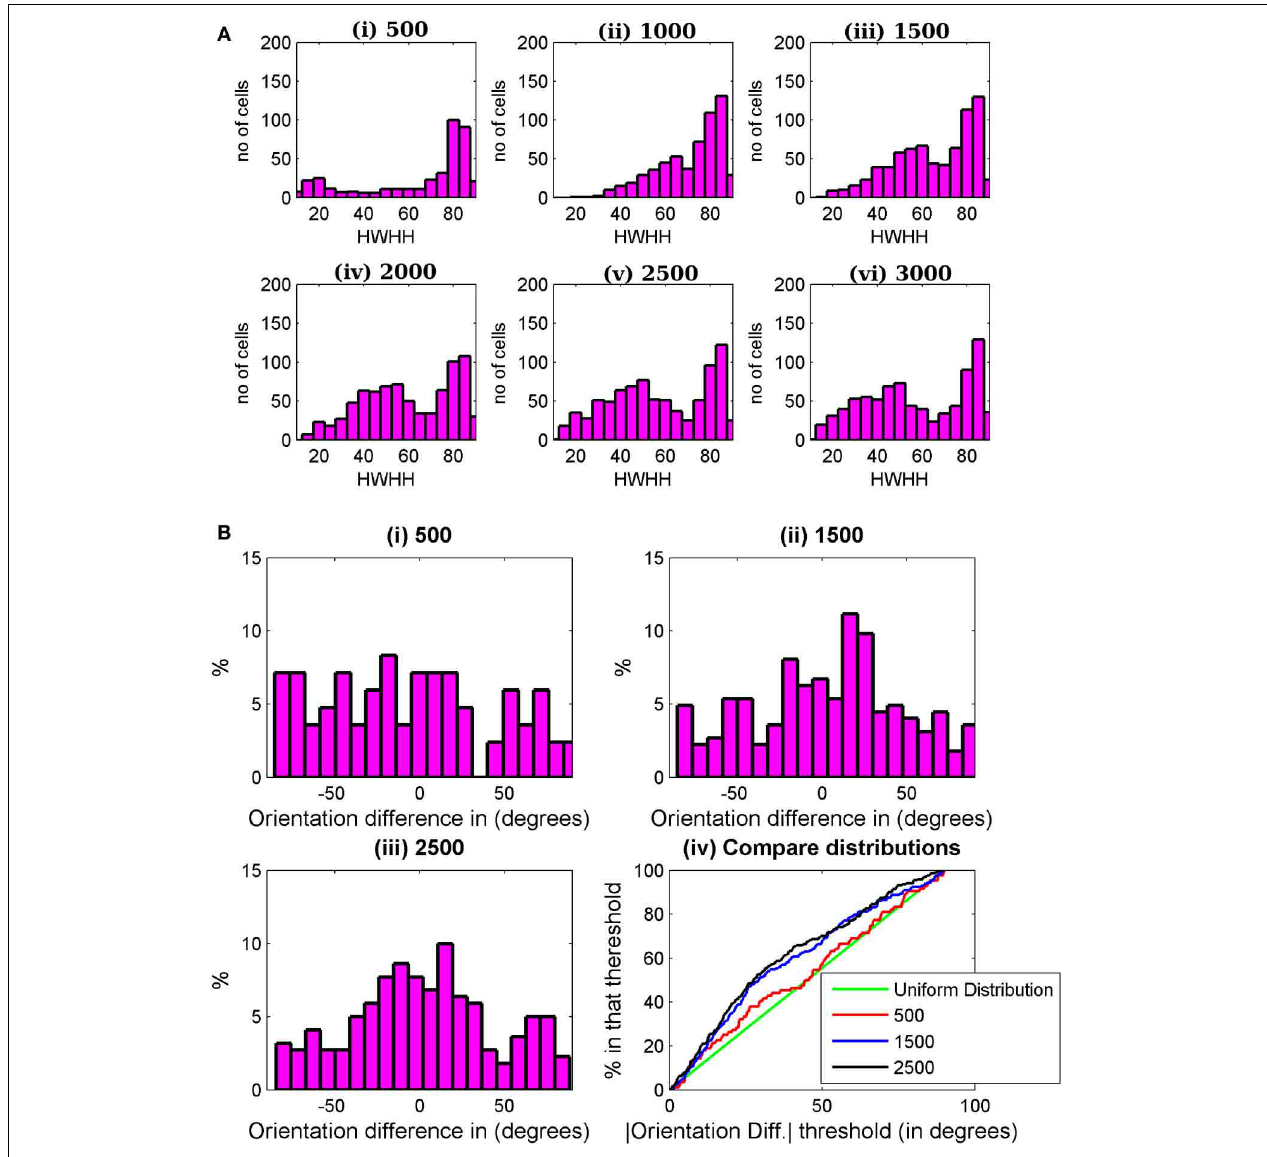
FIGURE 7 | (A) HWHH histogram for the cells in a 35 × 60 patch from the binocular region in the cortex. The histograms are shown from 500 to 3000 epochs at an interval of 500 epoch. (B) Histograms of preferred orientation difference between the two eyes at (i) 500, (ii) 1500, and (iii) 2500 epochs. In (iv) the histograms